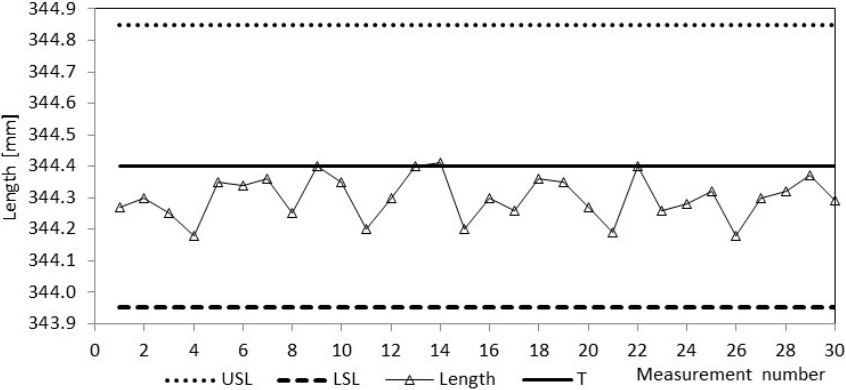
Figure 14. Measured data for the length parameter, first day [20].